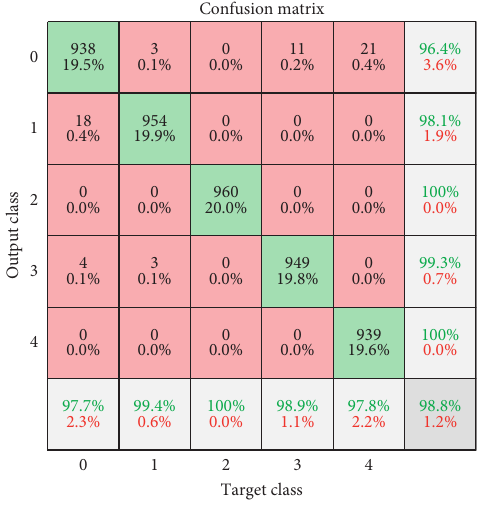
Figure 14: Statistics of CNN-FG.